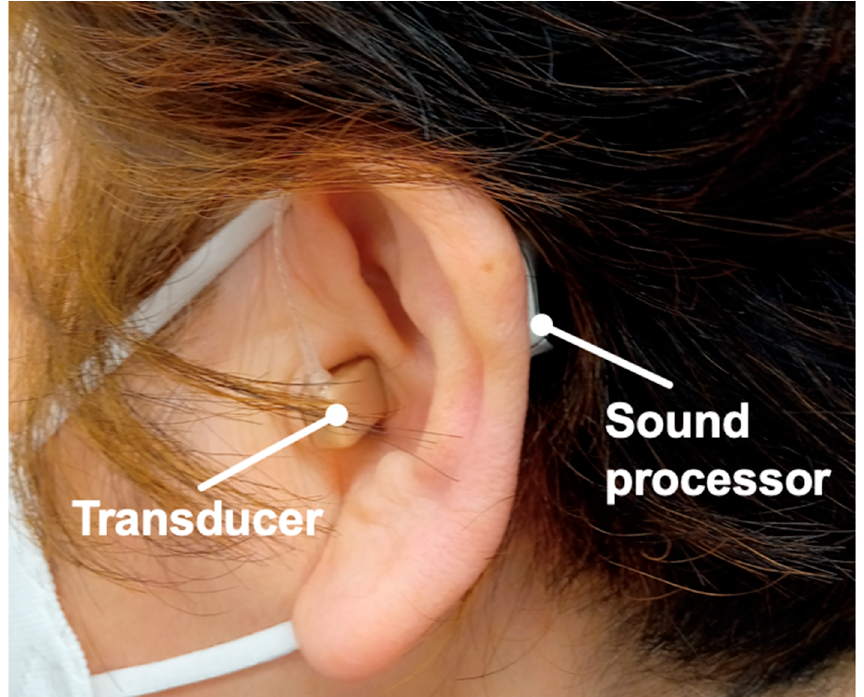
Figure 1. Example of ear with a cartilage conduction hearing aid (CC-HA). Profile views (left side) of a patient fitted with a CC-HA. Transducer and sound processor components of CC-HA are attached to the skin using double-sided adhesive tape.